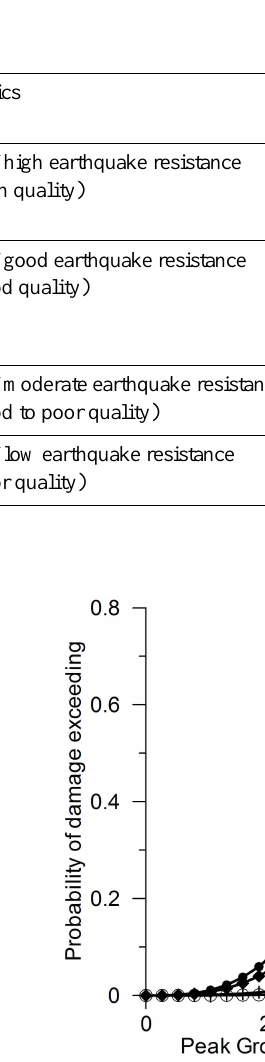
Fig. 5. Distribution of building constructions: high (type 1); good (type 2); good to poor (type 3); and poor (type 4) quality. Construc- tion free areas are marked by 5.